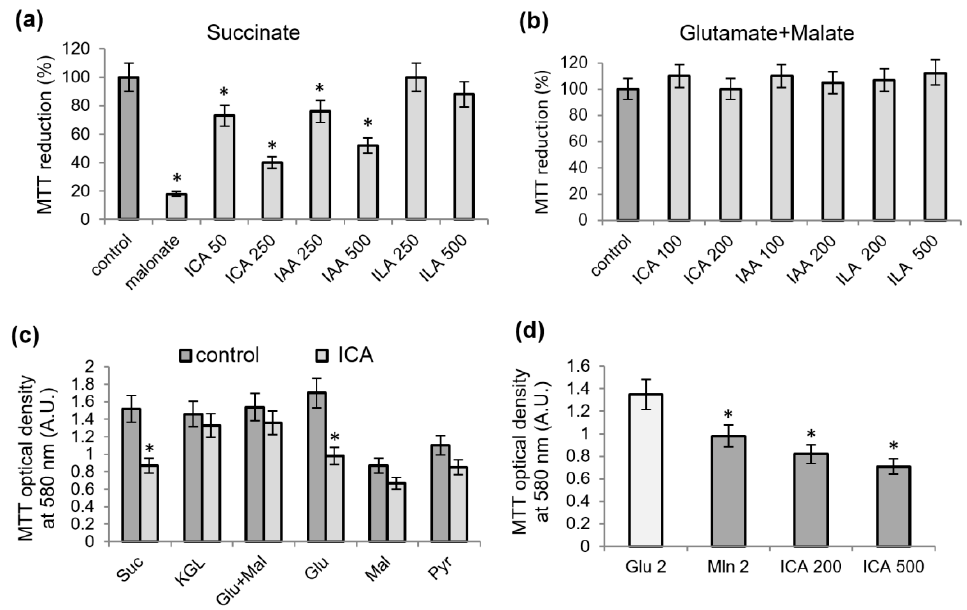
Figure 1. Influence of indolic acids on the oxidation of mitochondrial substrates, as measured by the MTT assay. MTT reduction (%) after a 5-min incubation of mitochondria with indolcarboxylic acid (ICA, 50 and 250 µ M), indolacetic acid (IAA, 250 and 500 µ M) and indollactic acid (ILA, 250 and 500 µ M), and succinate ( a ) or glutamate plus malate ( b ) as substrates of oxidation; influence of ICA (200 µ M) on MTT reduction after a 5-min incubation with mitochondria during the oxidation of succinate and NAD-dependent substrates ( c ); effects of malonate (2 mM) and ICA (200 and 500 µ M) on MTT reduction activated by glutamate ( d ). Substrates were added at a concentration of 2 mM. Asterisks (*) indicate values that differ significantly from the control values ( p < 0.05).